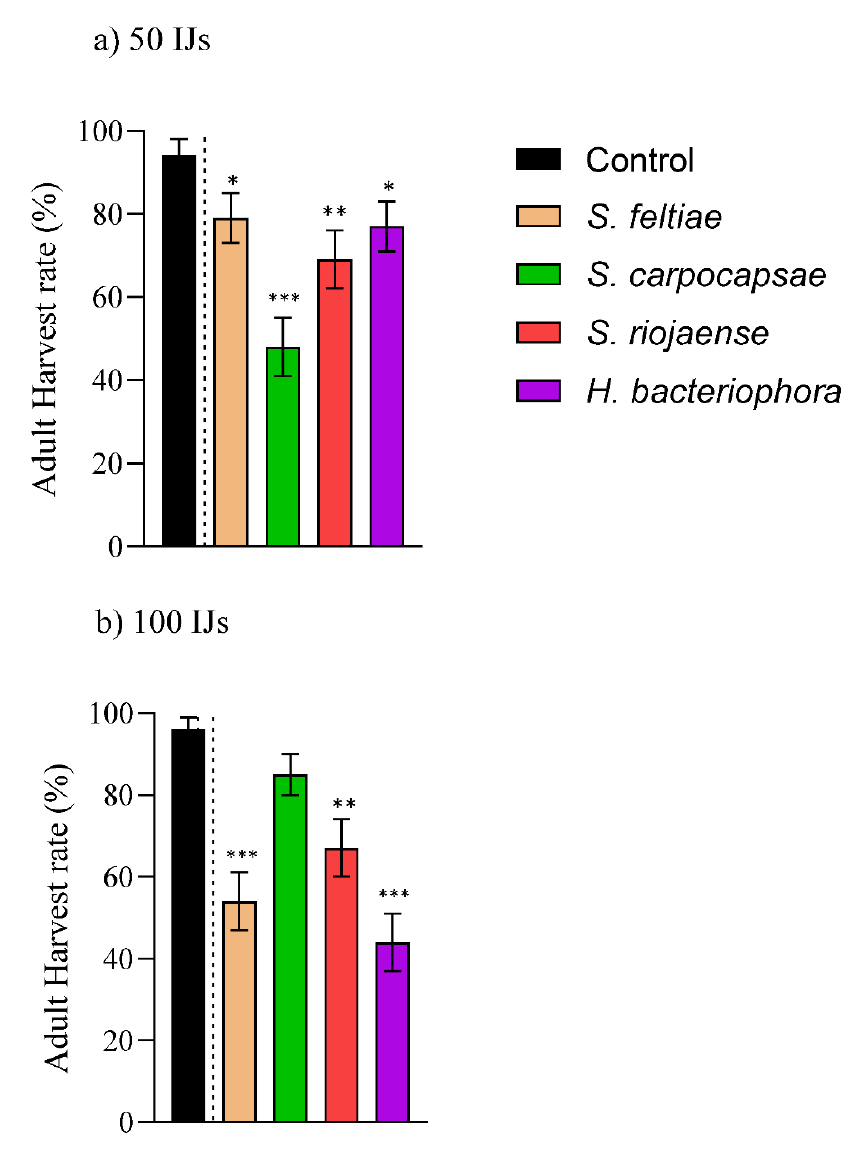
Figure 4. Virulence of infective juveniles (Ijs) of the Steinernema feltiae, S. carpocapsae, S. riojaense, and Heterorhabditis bacteriophora species against pupae of the European grapevine moth, Lobesia botrana . Concentration of ( a ) 50 IJs and ( b ) 100 IJs per pupa. Asterisks indicate significant differences at *** p <0.001, ** p <0.01, * p <0.05. Values are least-square means ± SE.